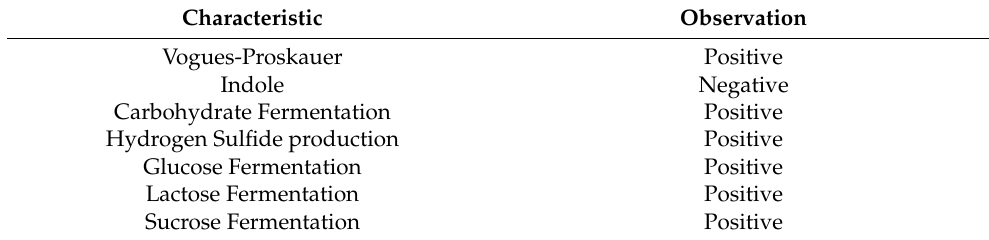
Table 2. Cont. Characteristic Observation Vogues-Proskauer Positive Indole Negative Carbohydrate Fermentation Positive Hydrogen Sulfide production